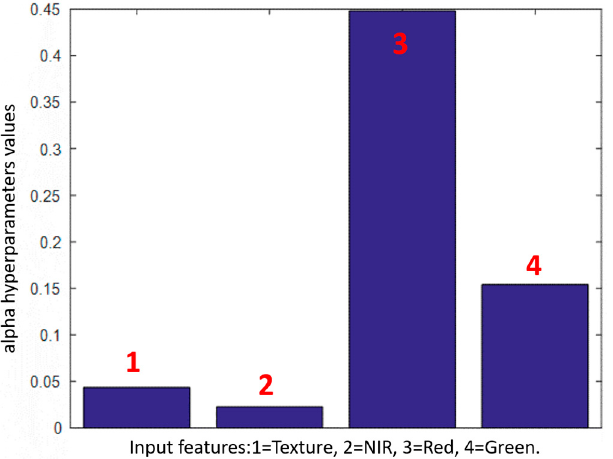
Figure 4. The alpha hyperparameters are shown for the four input features (1 = Texture, 2 = NIR, 3 = Red, 4 = Green).